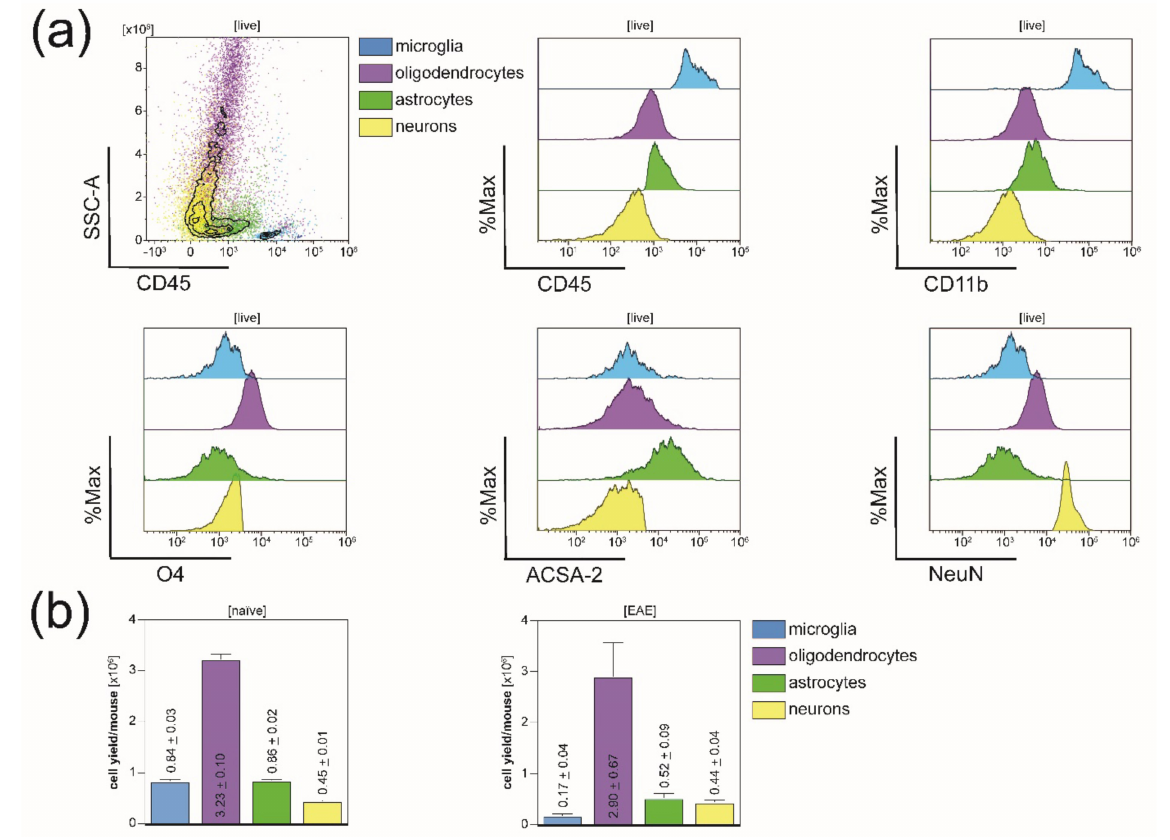
Figure 2. Phenotypic characterization pre-isolation and resulting cell yields post-isolation. ( a ) Flow cytometry analysis of one representative purified CNS homogenate pre-isolation using the same cell-type-specific markers included in panels for purity analyses post-isolation. ( b ) Cell yields per mouse and cell-type after applying the described protocol in naïve (on the left) and in EAE mice (on the right). Five biological replicates were measured for naïve mice, and four biological replicates were acquired in EAE mice. Respective means ± SEMs are indicated within the bar